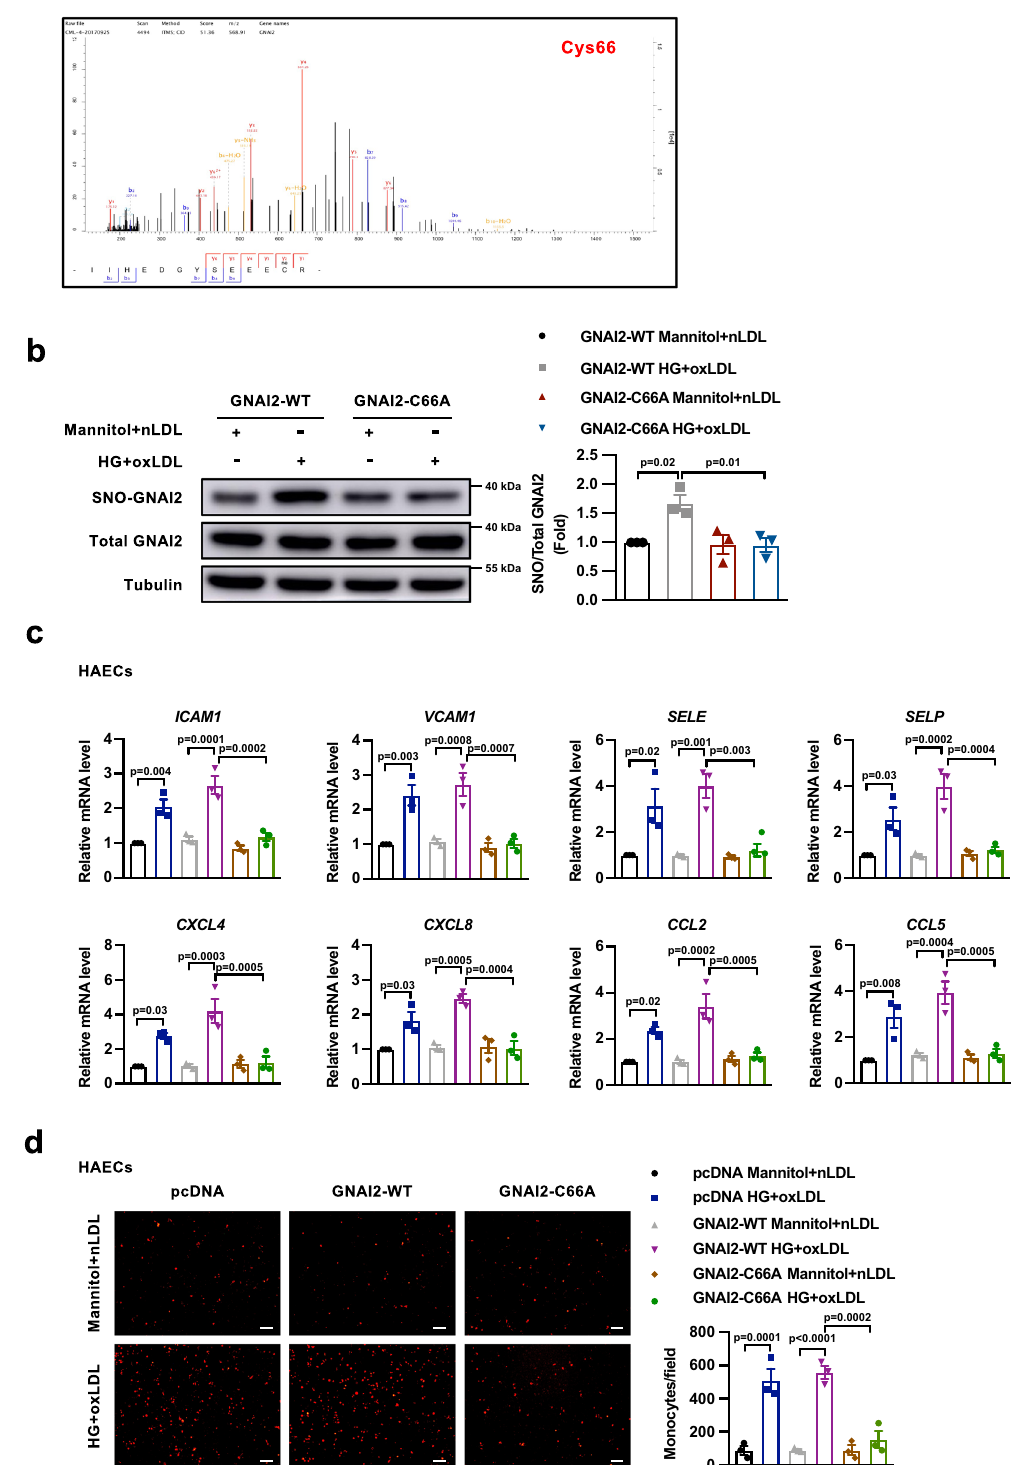
Fig. 2 Inhibition of GNAI2 S-nitrosylation at Cys66 alleviates HG- and oxLDL-induced in fl ammatory response. a Cys66 is identi fi ed as the SNO-site of GNAI2 according to the liquid chromatography-tandem mass spectrometry (LC-MS/MS) analysis. b HUVECs were ectopically expressed with GNAI2-WT and GNAI2-C66A, followed by exposure to HG and oxLDL for 24h. GNAI2-C66A abolishes S-nitrosylation of GNAI2 induced by HG and oxLDL as determined by